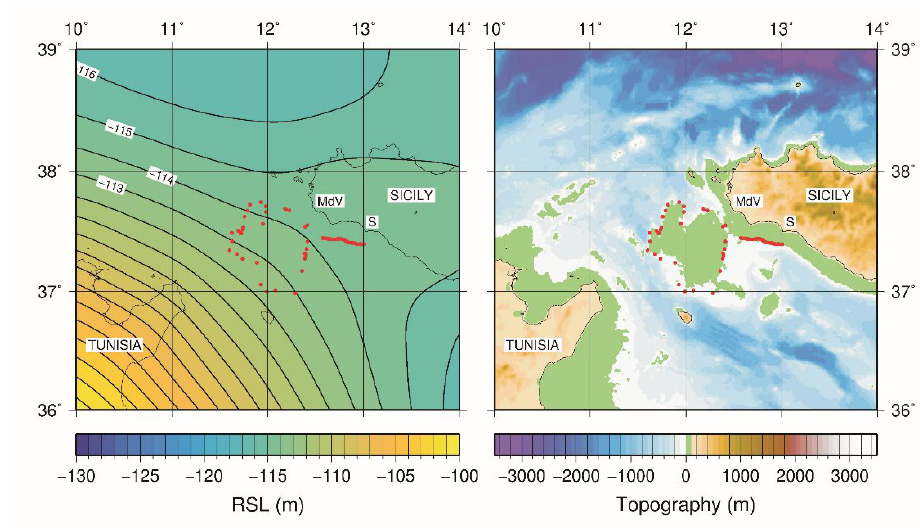
Figure 4. Relative sea level (RSL, left ) and palaeo-topography ( right ) at 21 kyears BP, according to the predictions based on the GIA model ICE-7G [37–39], obtained with the SELEN 4 solver. The palaeo-topography has been constructed by integrating the RSL map with the EMODnet bathymetry offshore and with the ETOPO1 global relief model [40] on land. Mdv: Mazara del Vallo; S: Sciacca. Red dots in Figure 4 mark locations of the palaeo-coastline derived from the geo-